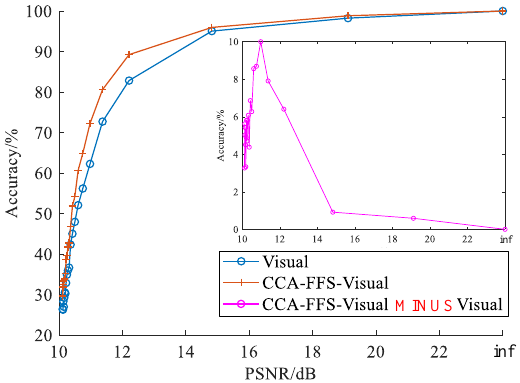
Figure 5. Recognition accuracies of the visual modality.